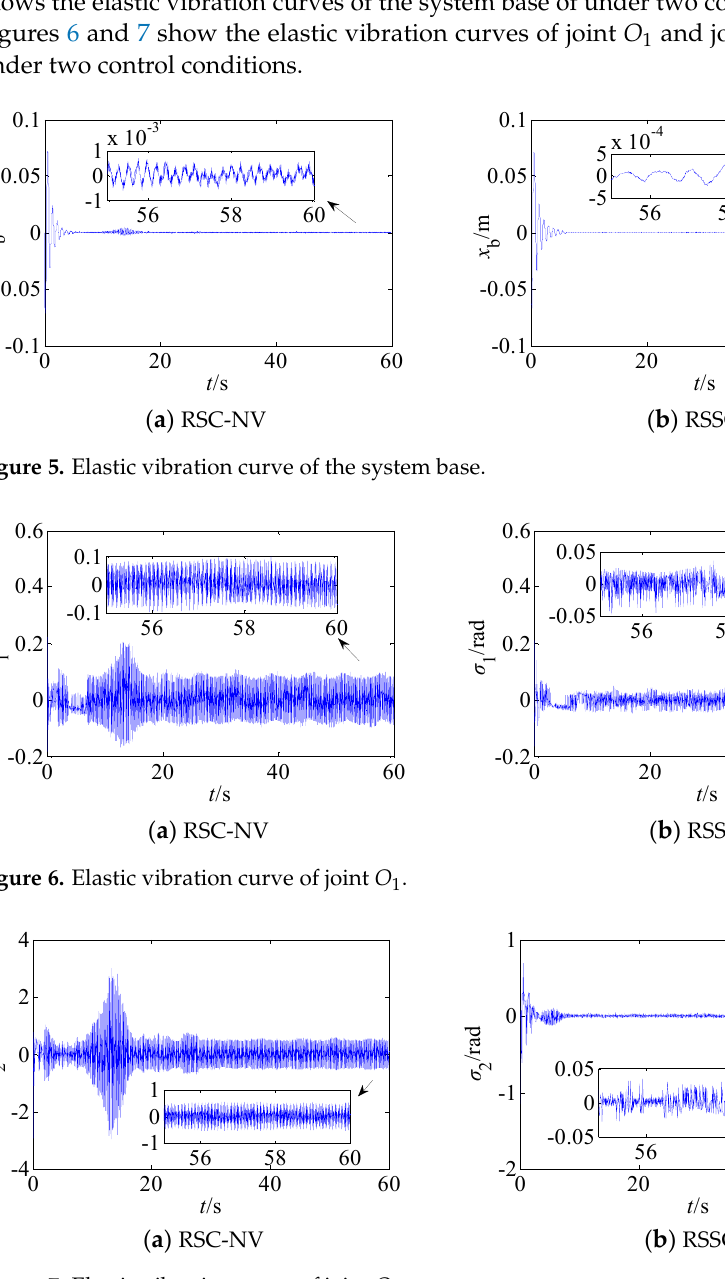
O . Figure 7. Elastic vibration curve of joint O 2 O . 2 O . 2 2